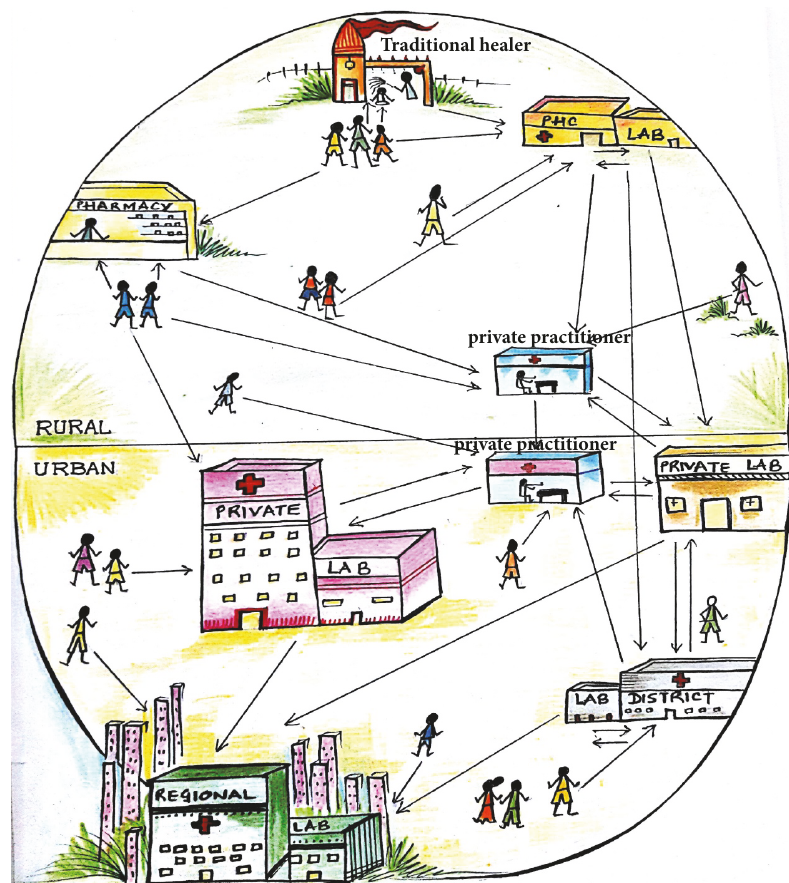
Figure 2: Illustration of health care practice of patients with extrapulmonary tuberculosis in rural and urban settings. The flow of patients between various care providers is unregulated, random, and haphazard. Few patients sought medical advice with the onset of disease. Many patients either practiced self-medication or first consulted any alternative care providers such as traditional healers or drug store/pharmacy for their illness. (PHC: primary health